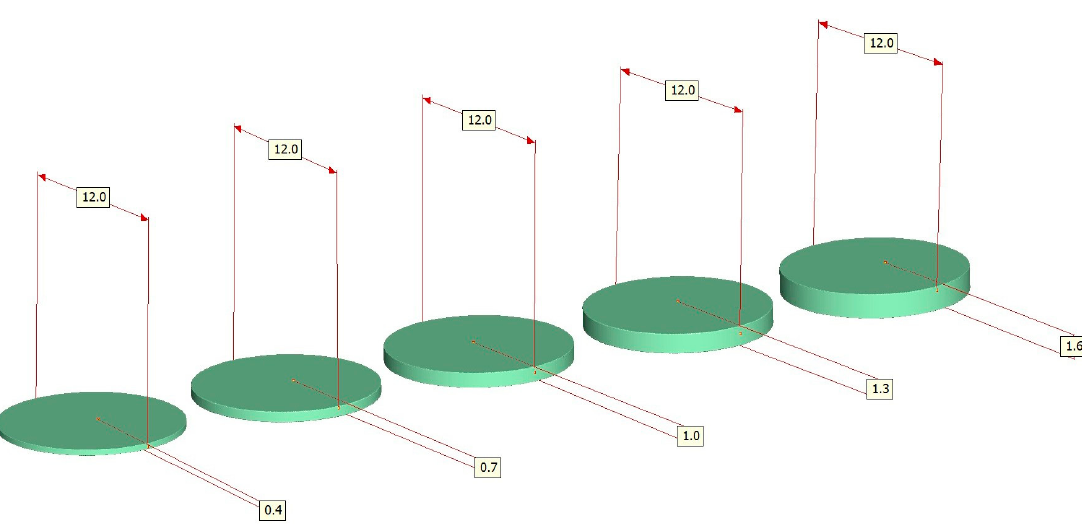
Figure 2. The shape and dimension of the test specimens used.